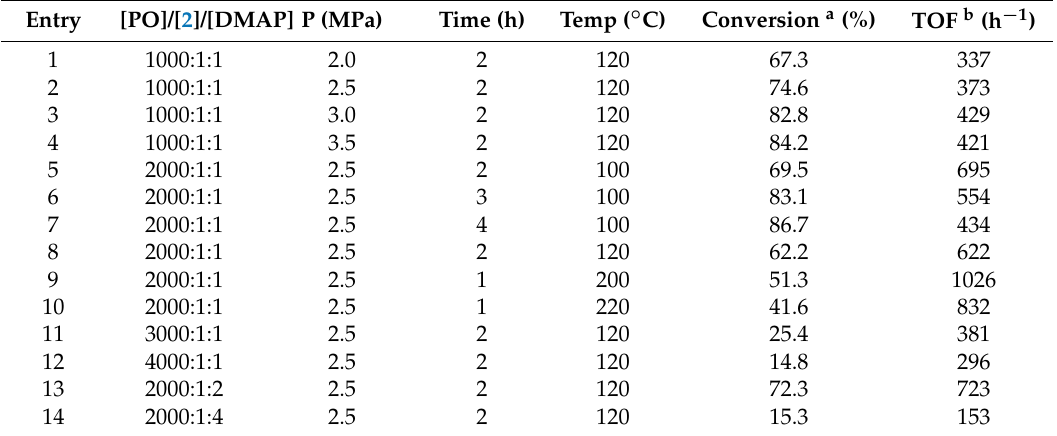
Table 4. Cycloaddition of PO to CO 2 in the presence of complex 2 /DMAP under various